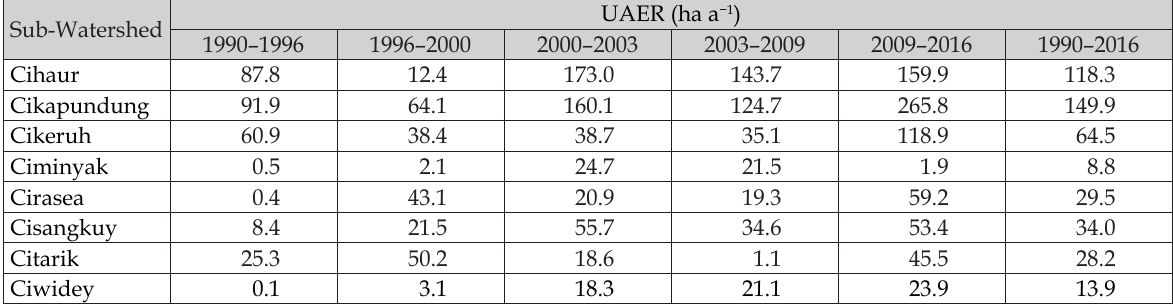
Table 3. The rate of urban/built-up area expansion in the eight sub-watersheds in the study area. Sub-Watershed Ciminyak